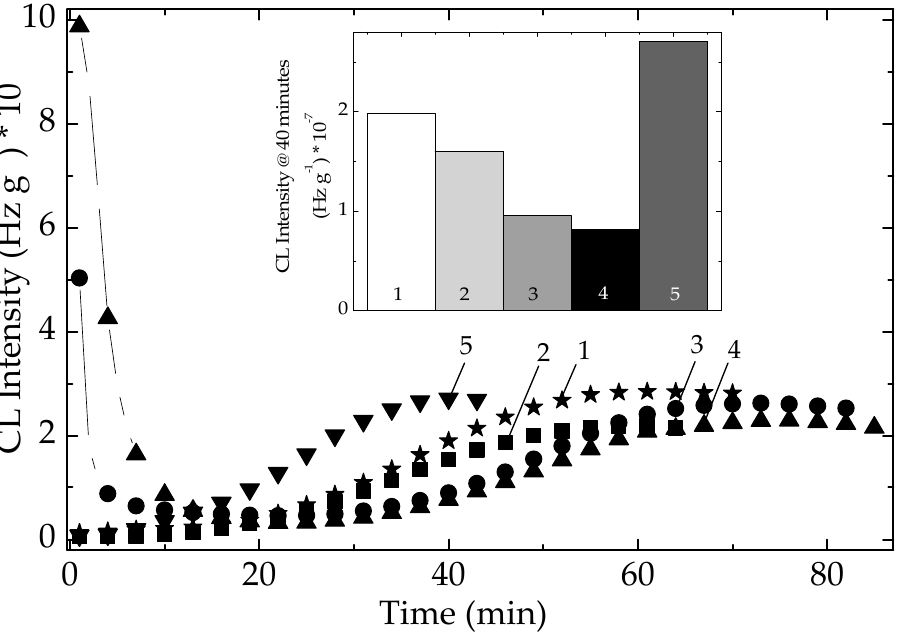
Figure 7. Isothermal CL spectra on unirradiated EPDM samples. Testing temperature: 170 °C. (1) Neat polymer; (2) EPDM/Ov-POSS 5; (3) EPDM/ Chlorella vulgaris ; (4) EPDM/ Spirulina platensis ; (5) EPDM/Ov-POSS 1.